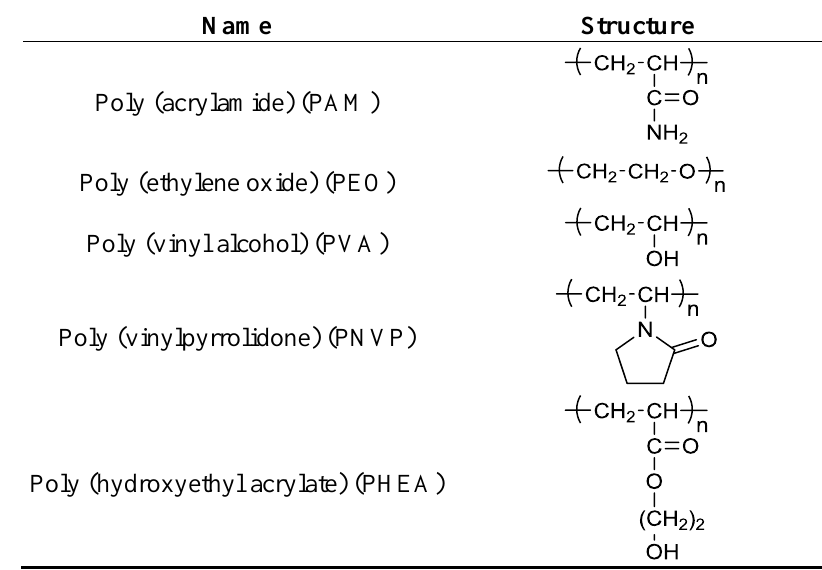
Table 1. Repeating units in representative nonionic homopolymers.